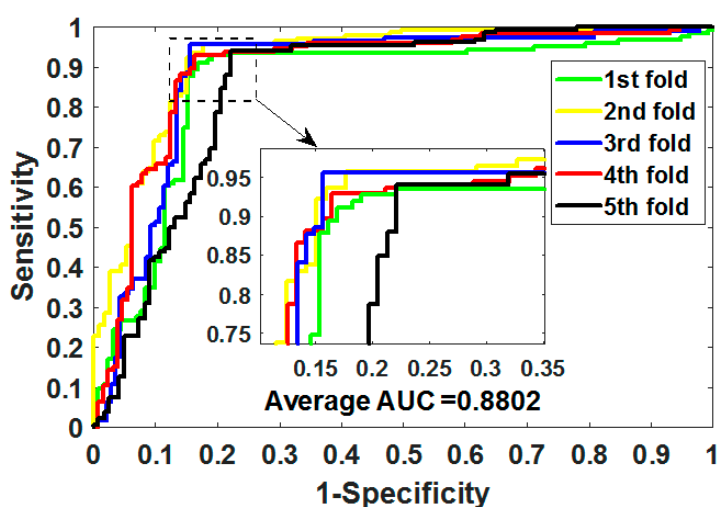
Figure 4. ROC of 5CV mapped by MSPEDTI on GPCR dataset.